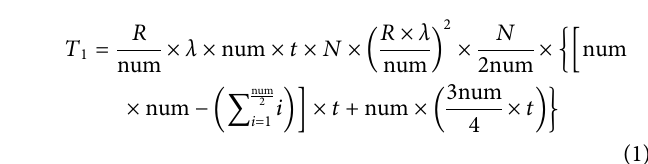
TABLE 1 | Power supply reliability of different wiring modes. Wiring mode